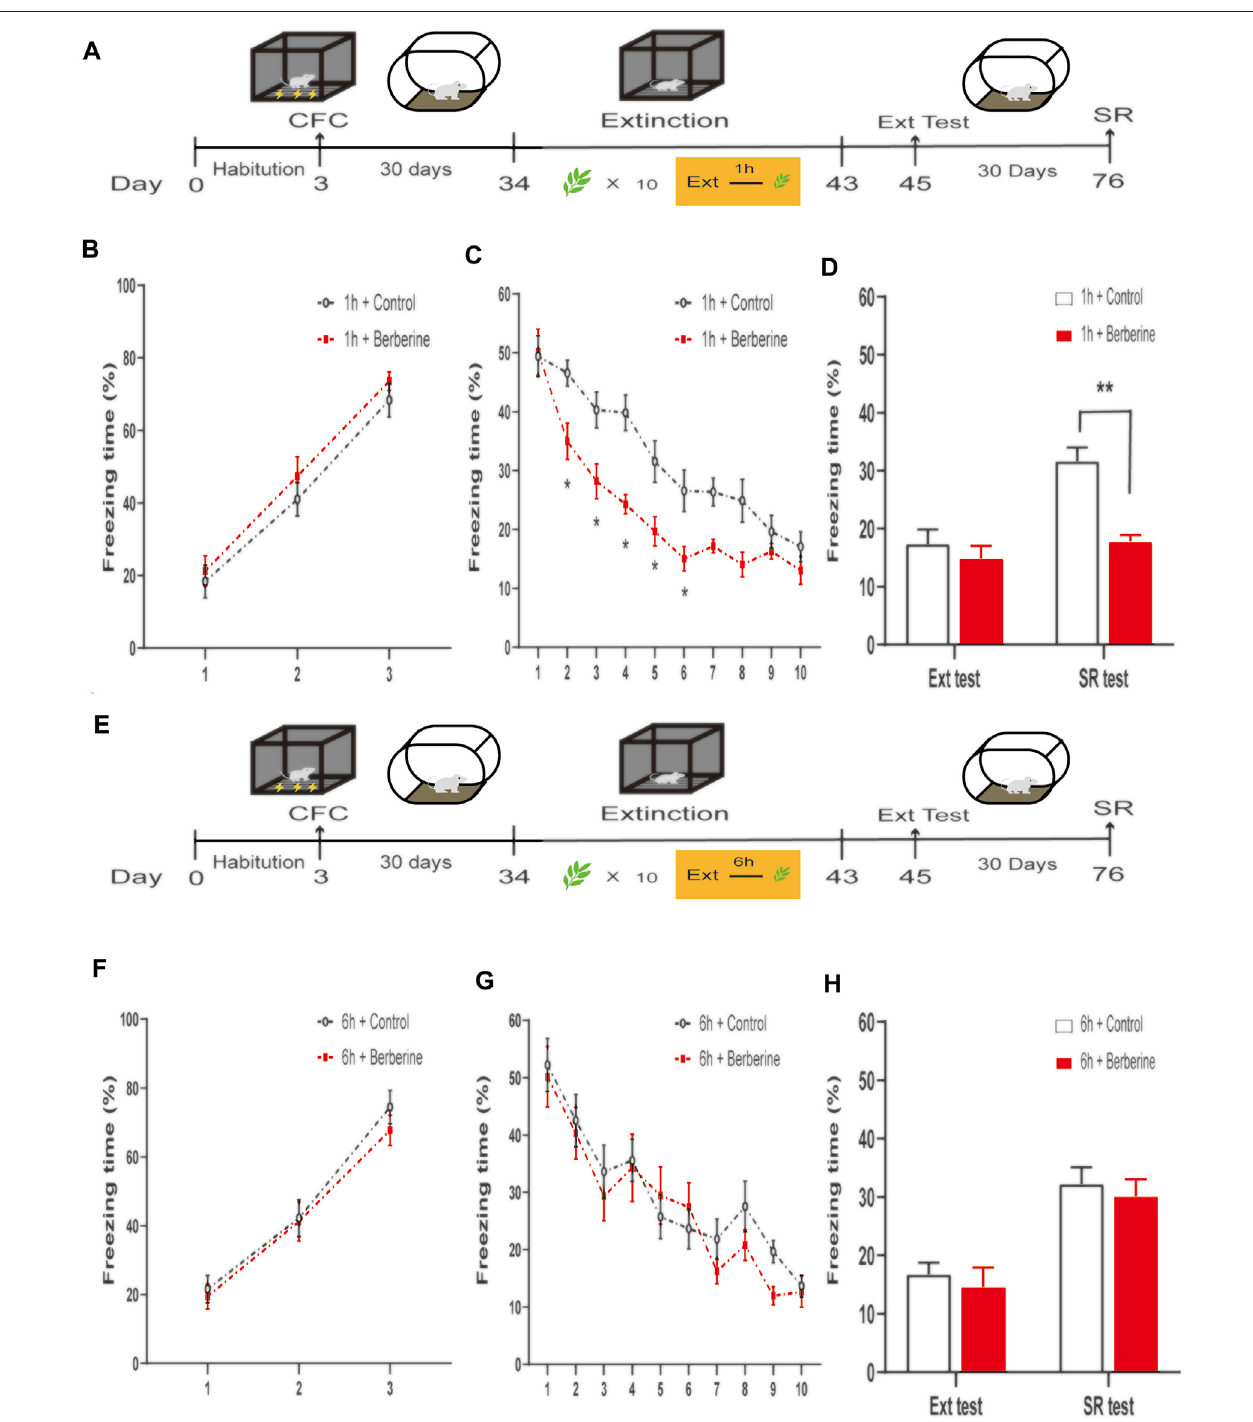
FIGURE 4 | | Berberine treatment 1 h after extinction enhanced extinction and reduced spontaneous recovery of remote fear. (A, E) Timeline of contextual fear conditioning, drug treatment, extinction training, extinction test, and spontaneous recovery test. (A) One hour or (E) 6 h after each extinction training session, corn oil (1 mL/kg, i.g.) or berberine (25 mg/kg, i.g.) was administered to mice, respectively. (B, F) Freezing levels during fear conditioning were similar between different groups. (C, G) Thirty days after CFC, freezing behaviors declined during extinction training sessions. (C) Repeated-measures ANOVA, effect of the training day, F (9,126) = 133.8, p < 0.001; Bonferroni post hoc test, p < 0.05, during the extinction training days 2 – 6. (D, H) Percentage of freezing time during extinction test (left) and spontaneousrecoverytest(right). (D) Signi fi cantfreezingtimewasobservedinSRtest, p < 0.01. n =8micepergroup.Dataaremeans±SEM,* p < 0.05,** p < 0.01,and compared with 1 h + control group. CFC, contextual fear conditioning; Ext, extinction; SR, spontaneous recovery.